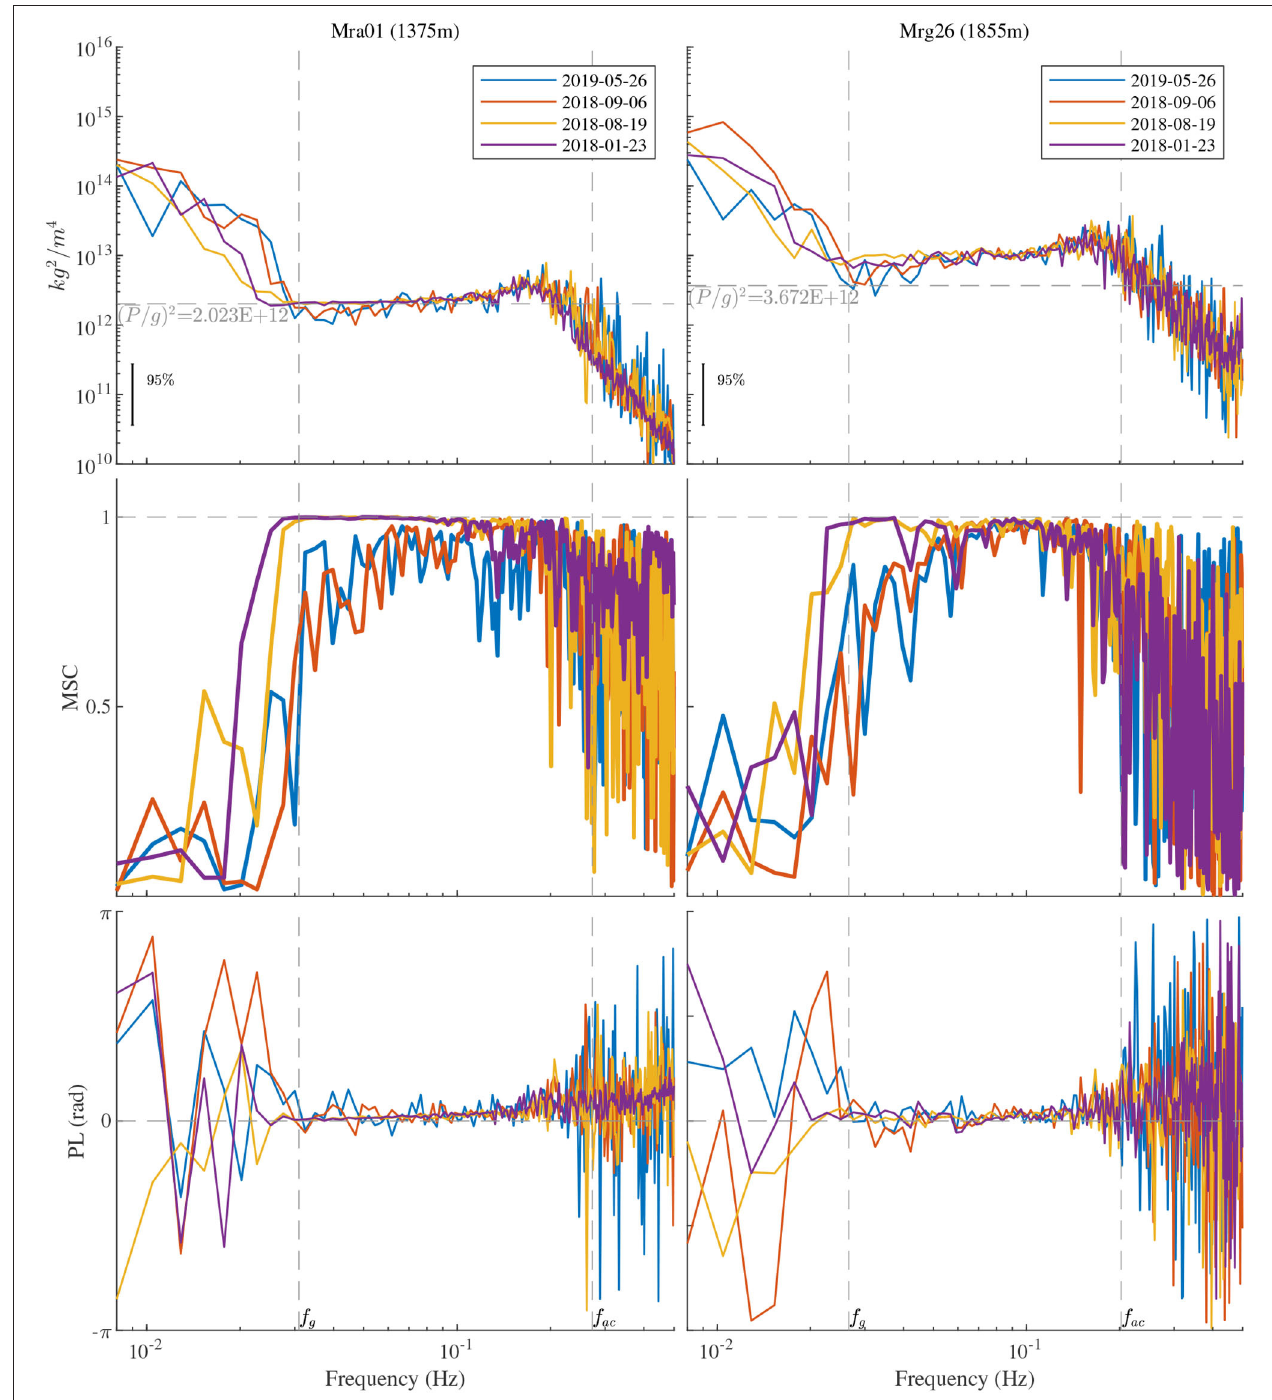
FIGURE 3 | Results of spectral processing of the signals registered by the PGs and z-accelerometers of the Mra01 (left column) and Mrg26 (right column) observatories. The colors of the curves correspond to the four seismic events dealt with (the dates are indicated in the legend). Fragments of the figure from top to bottom are: the ratio of power spectra of variations of the ocean bottom pressure ( p ) and the z-acceleration ( a z ), the cross-spectrum of signals p and a z (magnitude-squared coherence—MSC and Phase Lag—PL). The vertical dotted lines show the positions of frequencies f g and f ac , that are limits imposed on the range of “forced oscillations.” The horizontal dotted line in the upper row of fragments and the numbers under it show the value of ( P / g ) 2 .